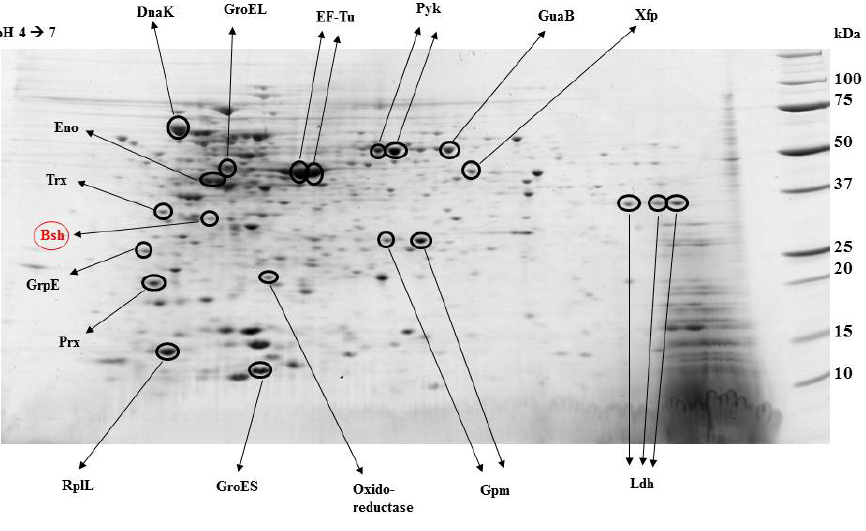
Figure 2. Protein studies using 2-D gel electrophoresis have documented the presence and activity of bile salt hydrolase in BB-12 ® . Marked as Bsh in the picture. Reproduced from Garrigues et al . 2005 [3] with permission of Dairy Industry Association of Australia, Copyright